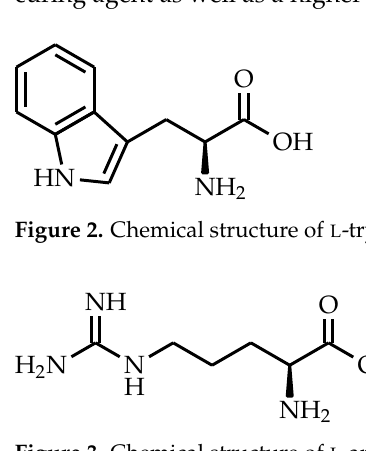
Figure 3. Chemical structure of L